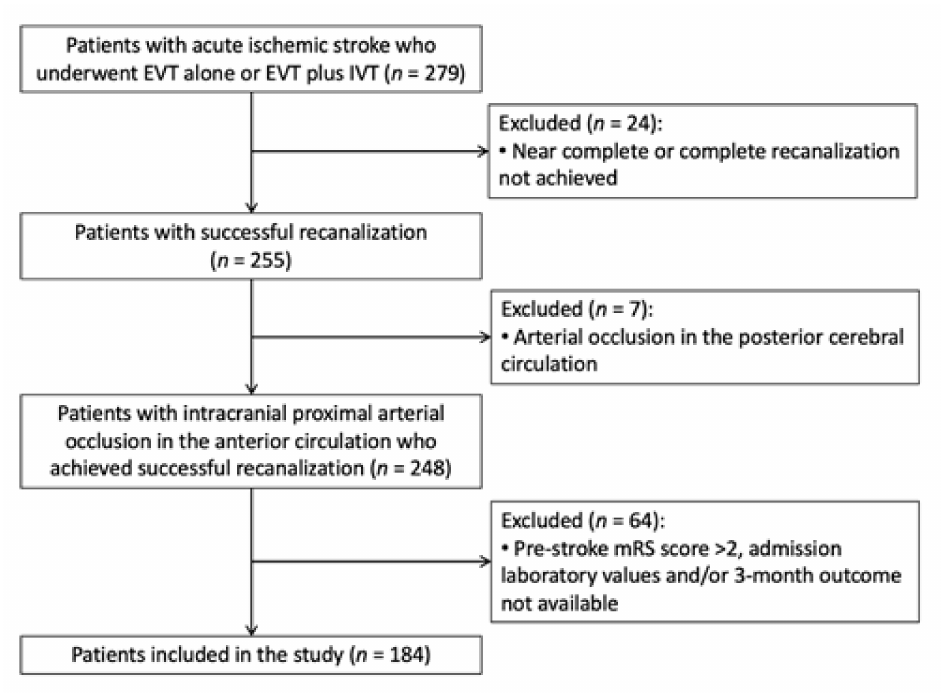
Figure 1. Patient selection flow diagram. Abbreviations: EVT—endovascular treatment, IVT—intravenous thrombolysis, mRS—modified Ranking